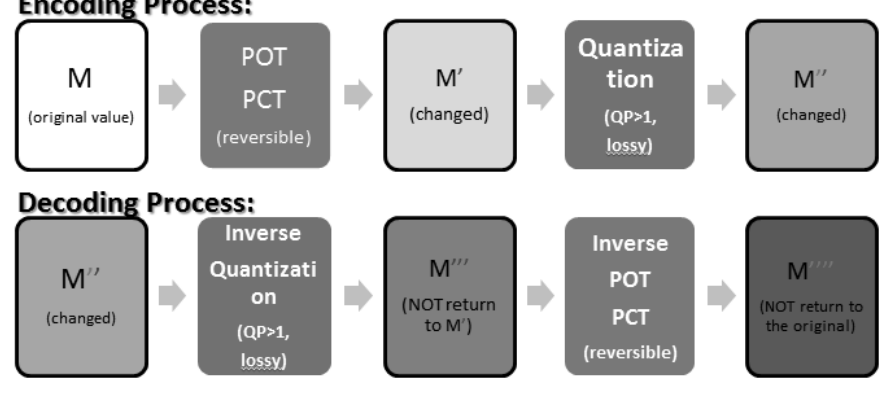
Figure 7. The “irreversibility” when QP > 1.